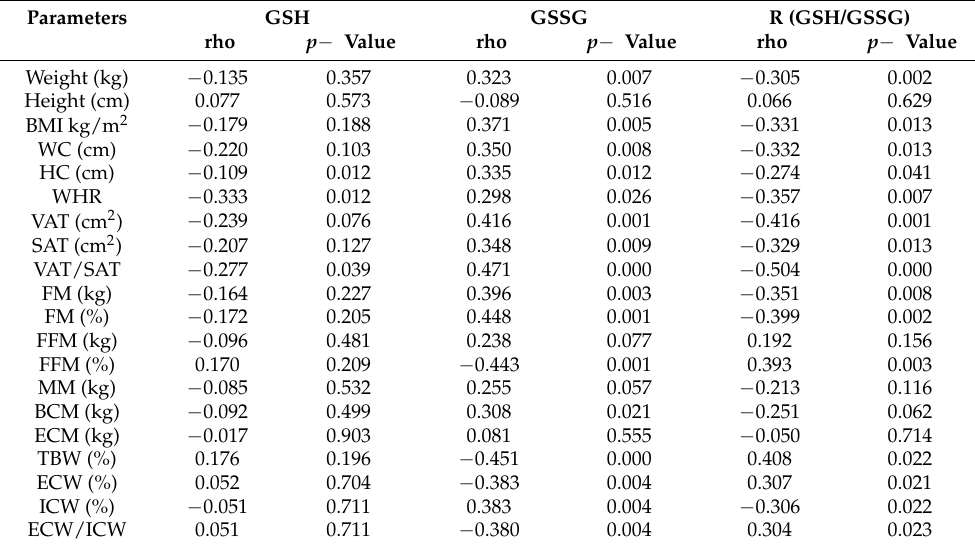
Table 5. Spearman’s rank correlation coefficients between GSH, GSSG, as well as R-index and anthropometric parameters in women with PCOS.